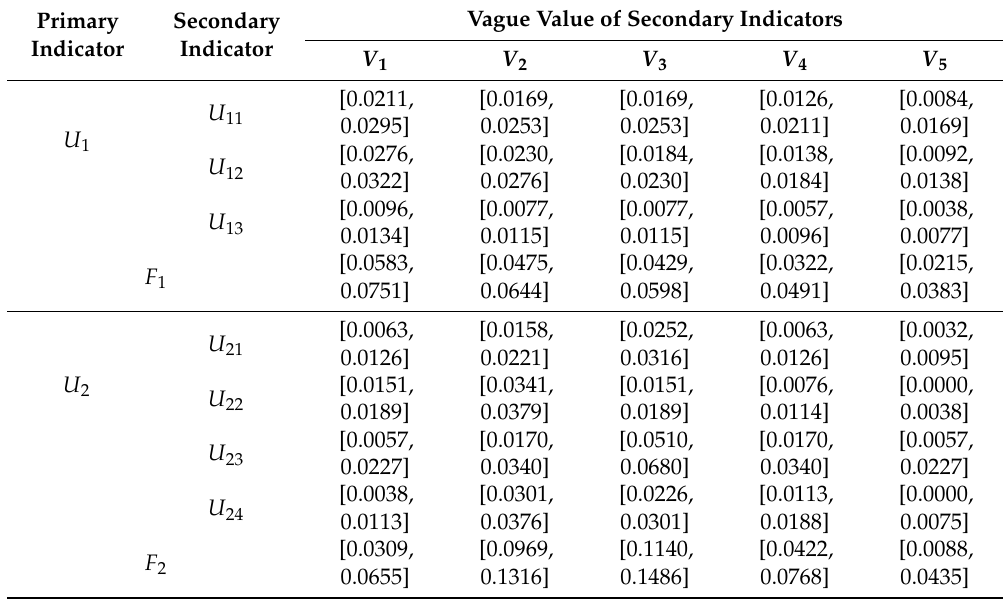
Table 8. Comprehensive evaluation result of Vague value (Project